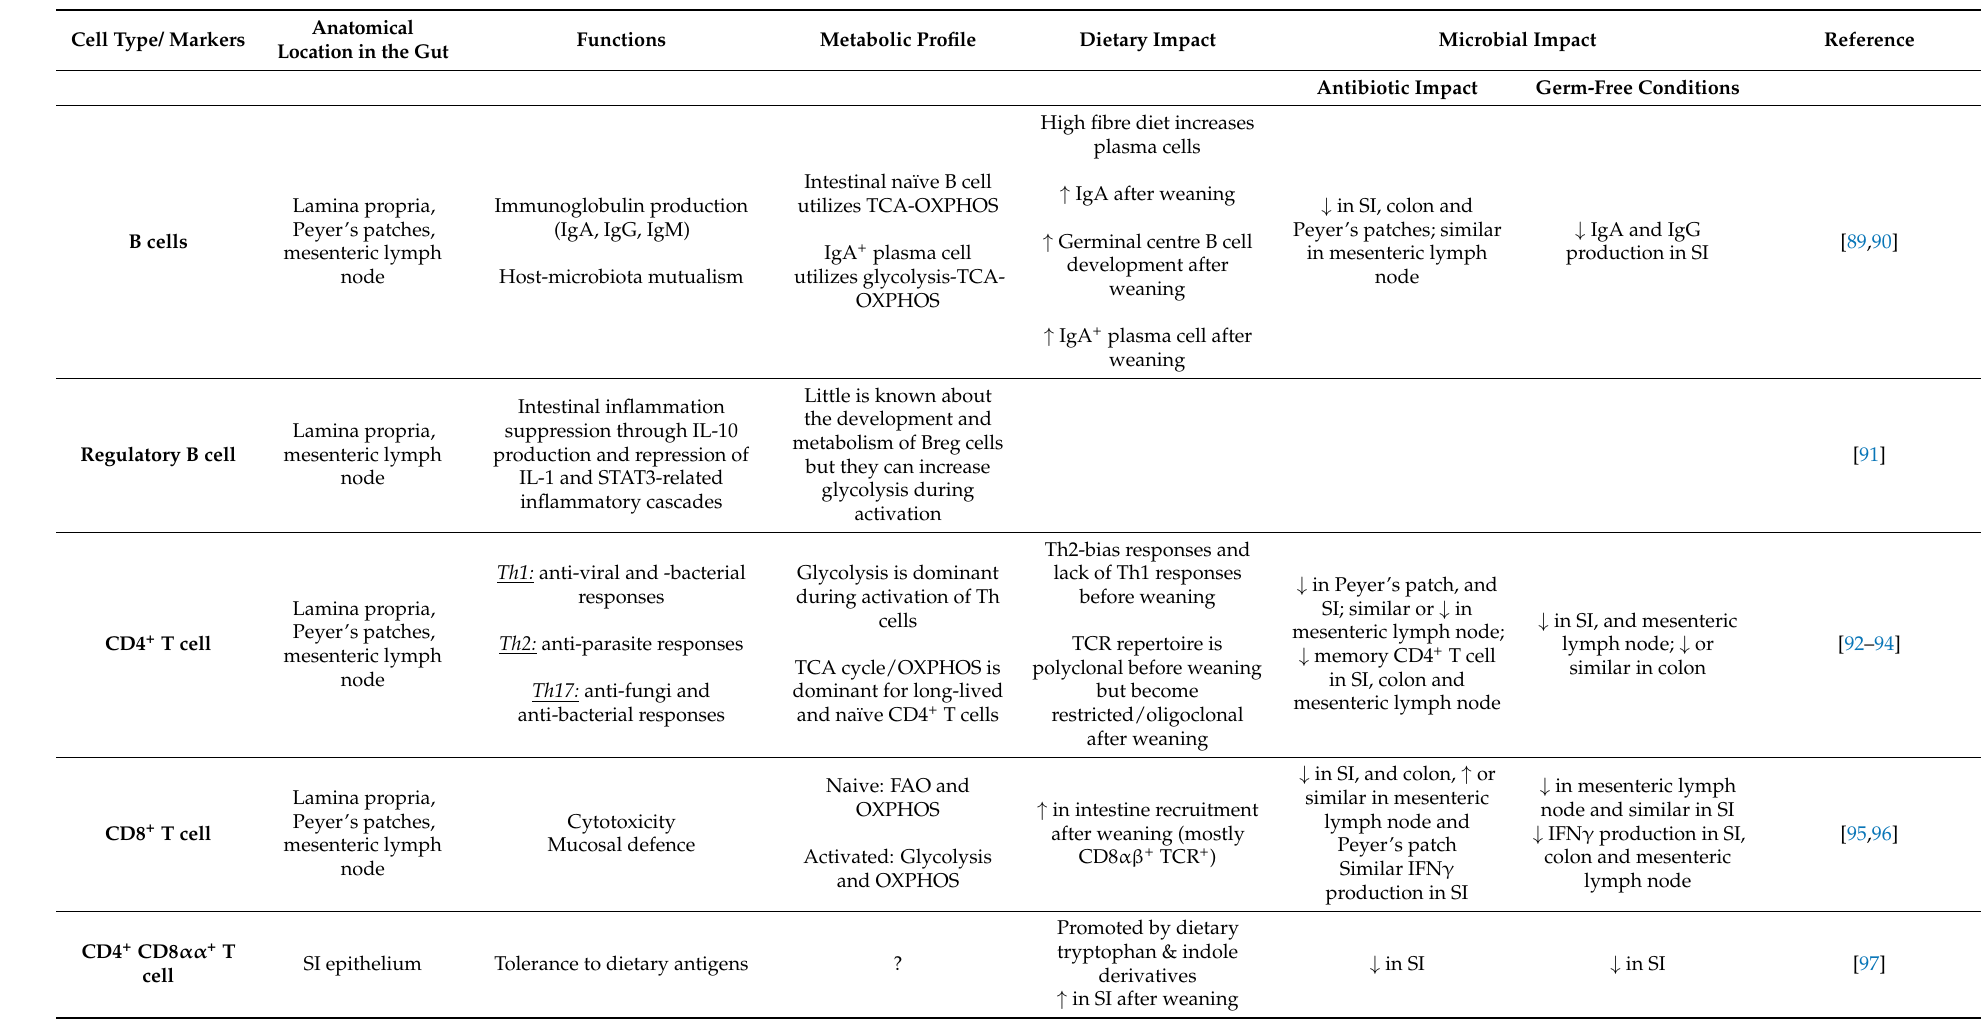
Table 1. Cells of the gut immune system, their main anatomical location in the gut, their function and their regulation by diet and the gut